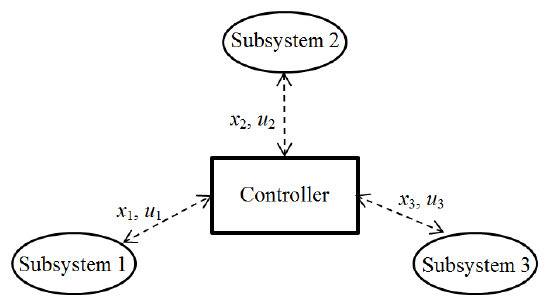
Figure 3. Self-triggered control